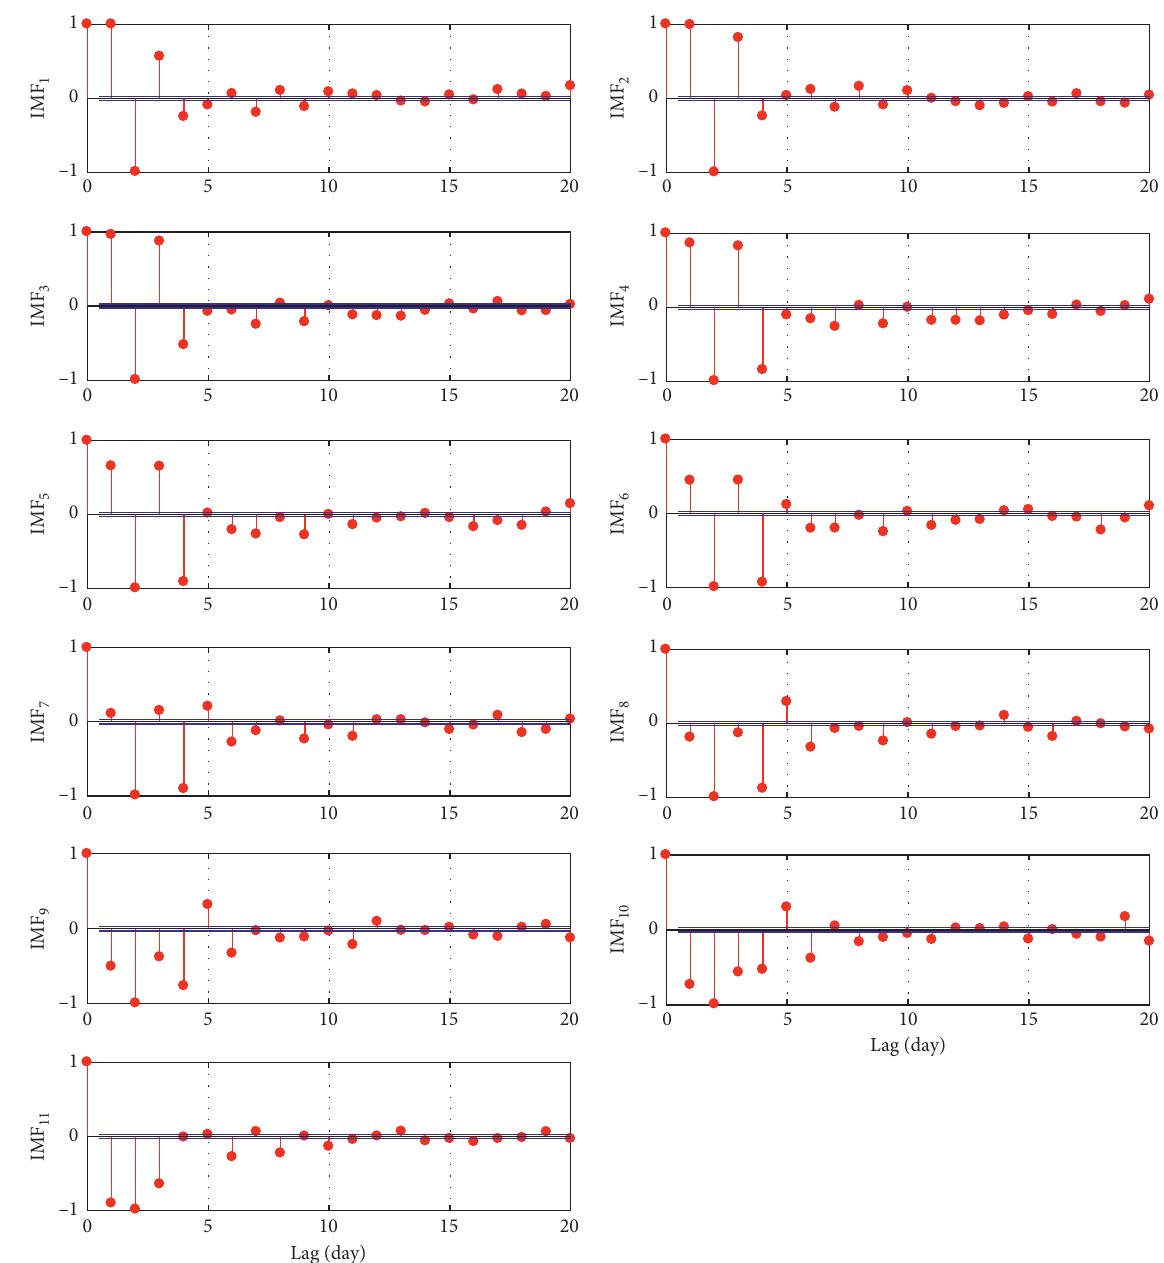
Figure 5: The PACFs of the raw data and IMF series that are obtained by the VMD at the Weijiabao